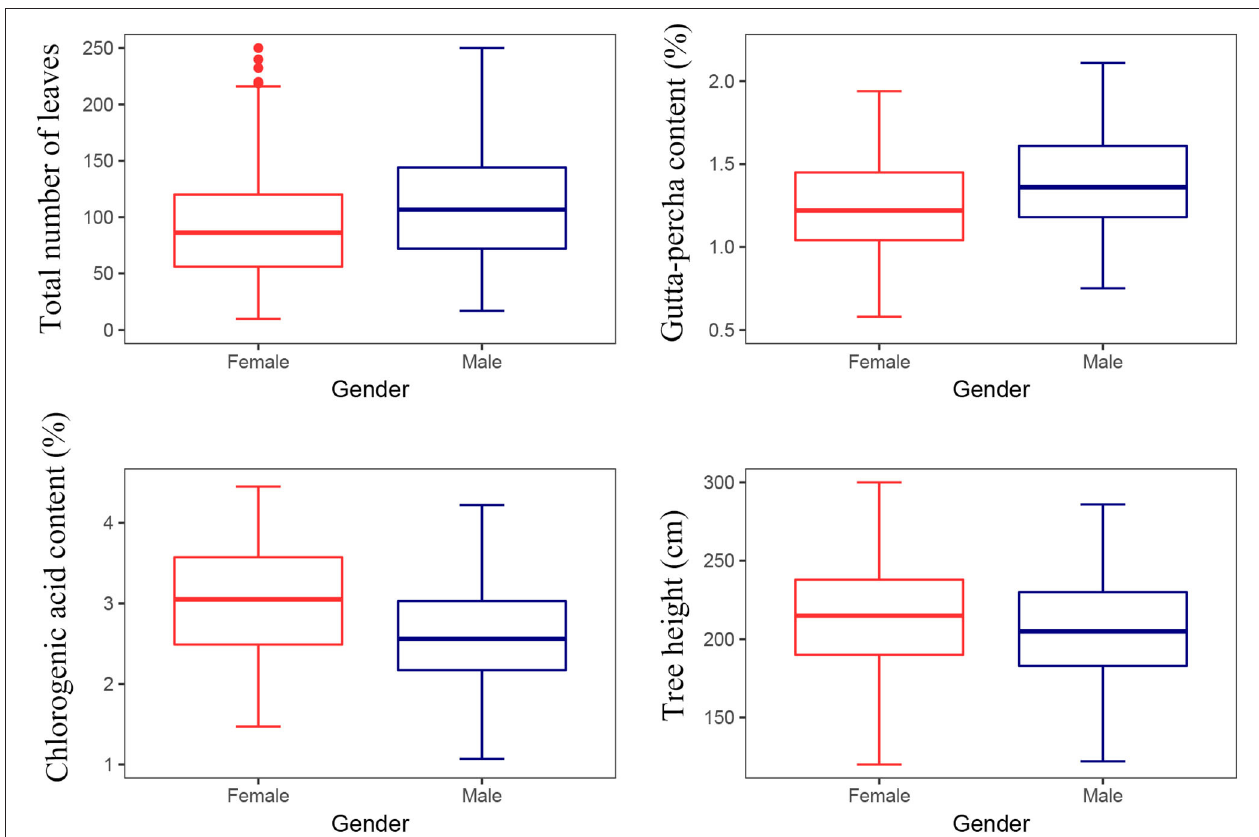
FIGURE 6 | Multiple comparisons for traits between the